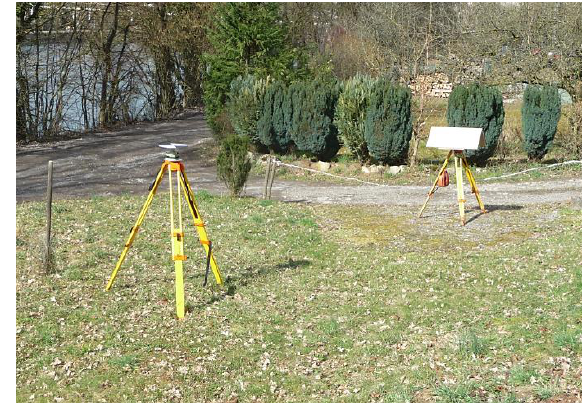
Figure 4. Photogrammetric control point (left) and LiDAR control surface (right) mounted on